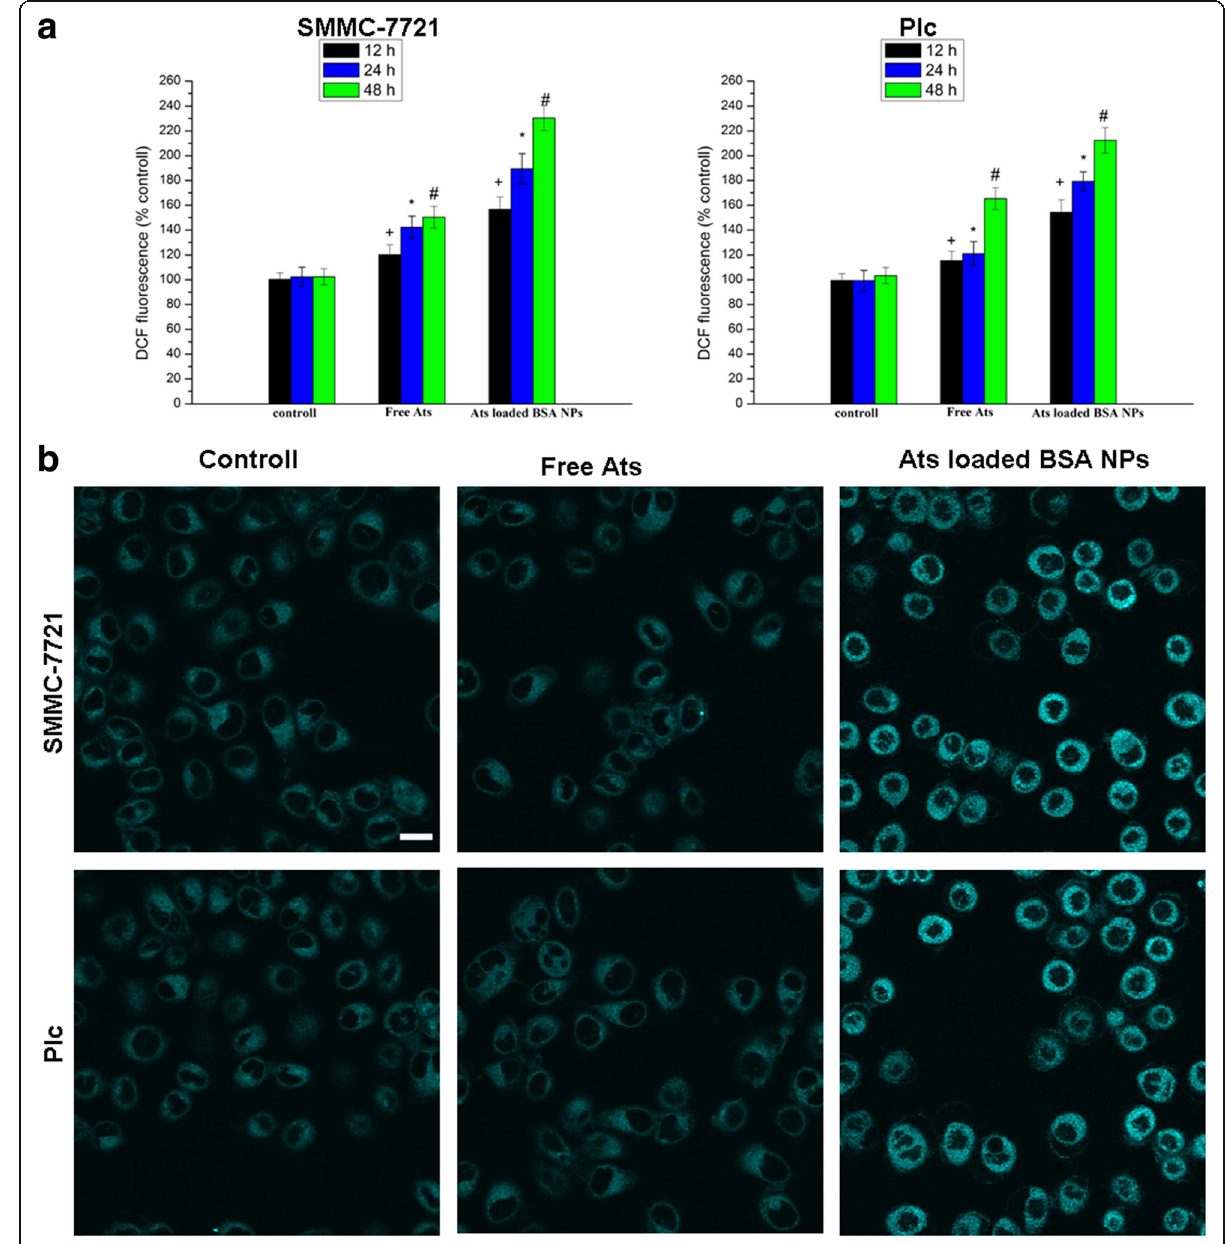
Fig. 4 Quantification of ROS generation in cells treated with free Ats and Ats-loaded BSA NPs at different times ( a ). ER staining with the ER-Tracker Blue – White DPX probe ( b ). Scale bar , 100 μ m. The data are presented as the mean±SD ( n =3). + P <0.05 versus the control group at 12 h, * P <0.05 versus the control group at 24 h, # P <0.05 versus the control group at 24